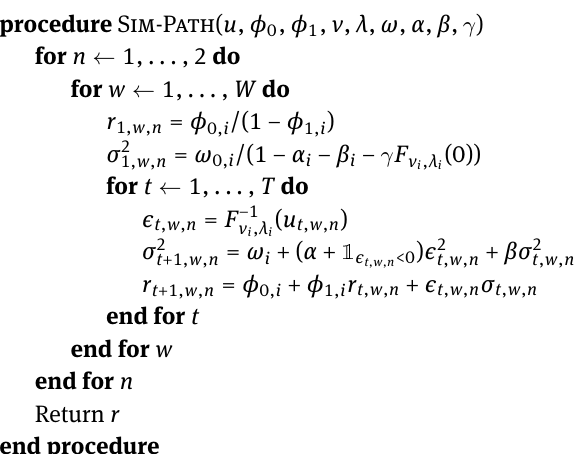
Algorithm 2: Simulation from a AR(1)-TGARCH(1,1) over a time period T and skewed t distribution assumption for the innovation process.